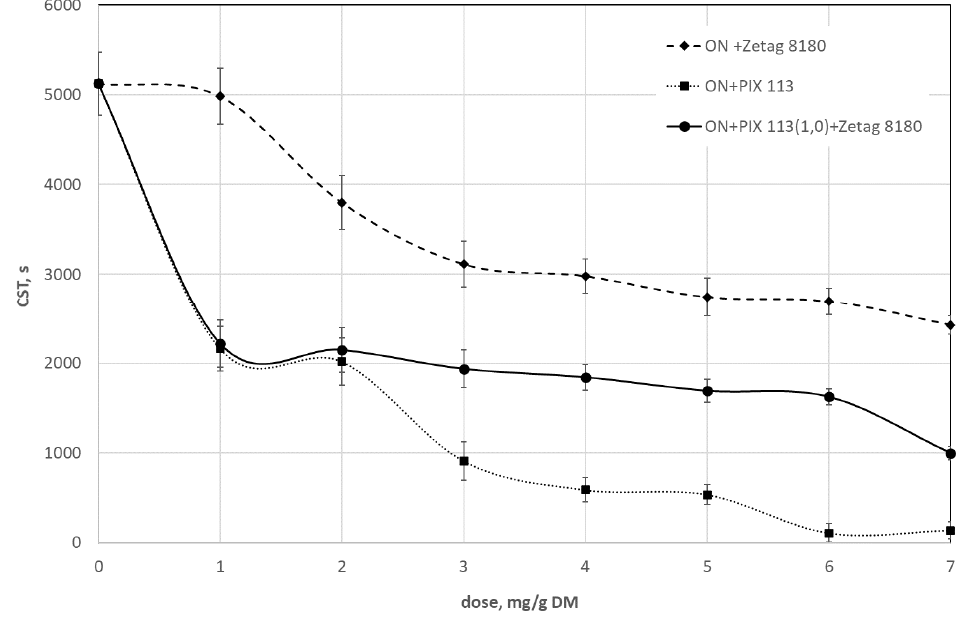
Figure 2. Effect of the dose of selected chemicals on CST of sonicated sludge (A 2 = 45.75 µm).